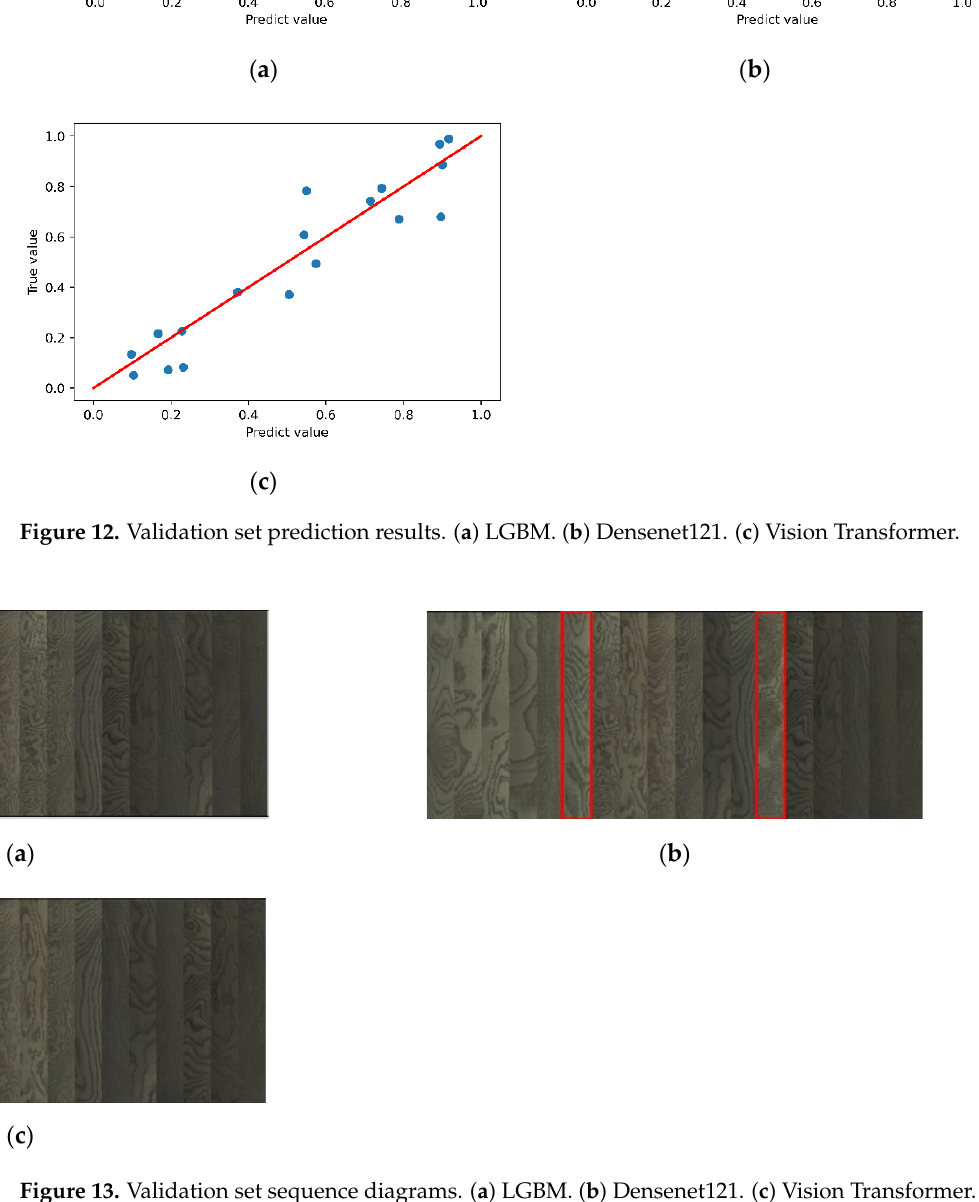
Figure 12. Validation set prediction results. ( a ) LGBM. ( b ) Densenet121. ( c ) Vision Transformer. Table 2. Statistical magnitude of true and predicted values in the validation set.